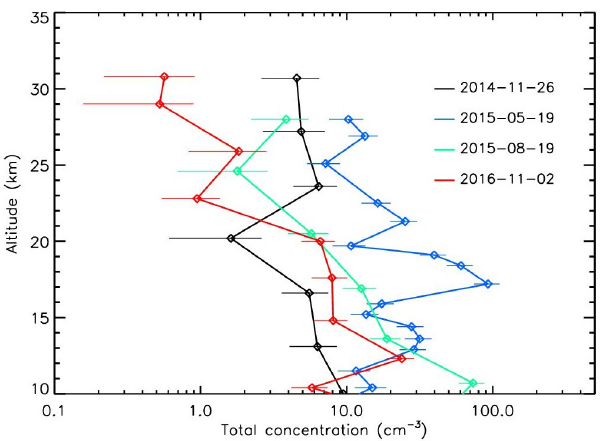
Figure 10. Total number concentration of aerosol (0.2–50µm) pro- files obtained from LOAC OPC observations over Reunion on 26 November 2014 (black line), 19 May 2015 (blue line), 19 Au- gust 2015 (green line), and 2 November 2016 (red line).